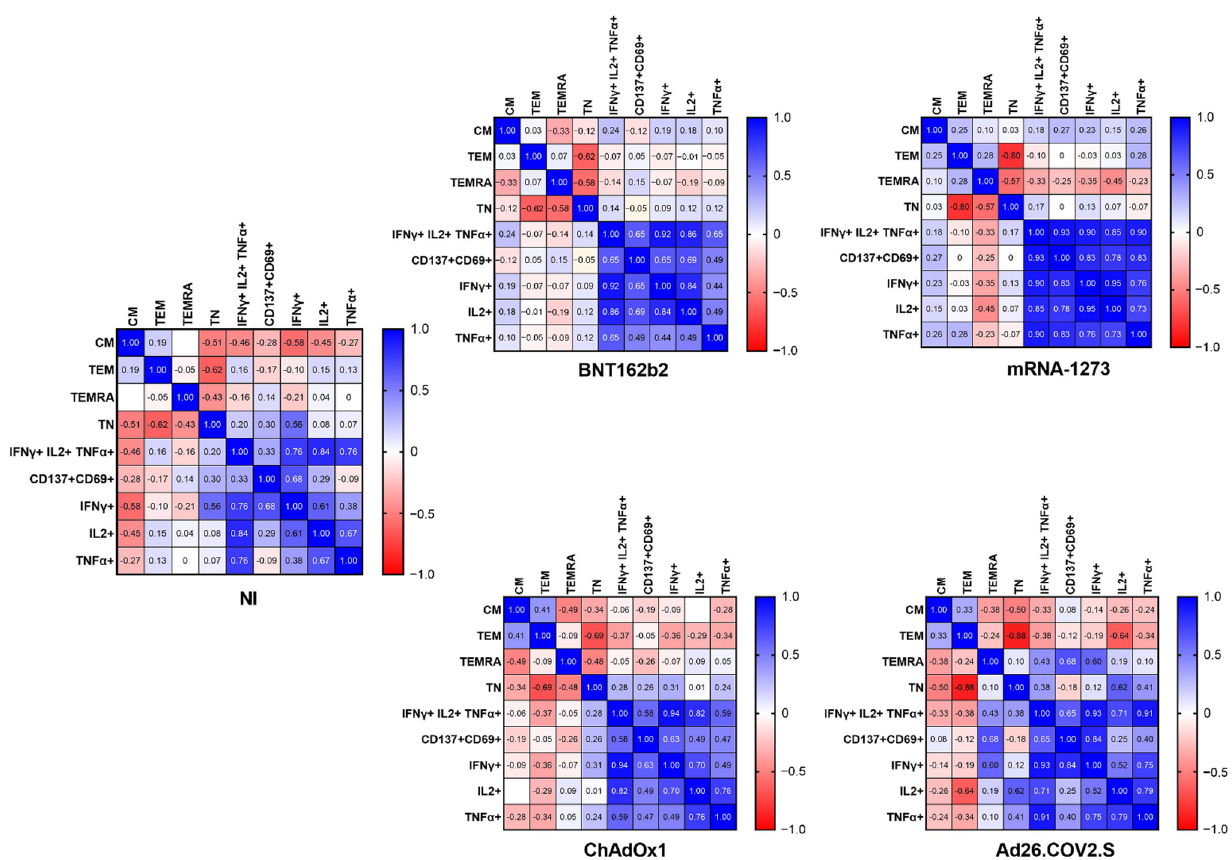
Figure 4. Correlation analysis between CD8 + T-cell subpopulations and produced cytokines. Correlation analysis was performed for NI and each vaccine platform. Each comparison shows a value representing the correlation strength between different sets of variables. Spearman’s rank correlation test was carried out to assess the correlation and calculate cutoff values. Values below or above the cutoff were considered statistically significant ( p -value < 0.05) and reported as follows: NI: cutoff >+0.51; ChAdOx1: cutoff >+0.47; BNT162b2: cutoff >+0.33; mRNA-1273: cutoff >+0.73; Ad26.COV2.S: cutoff >+0.75.